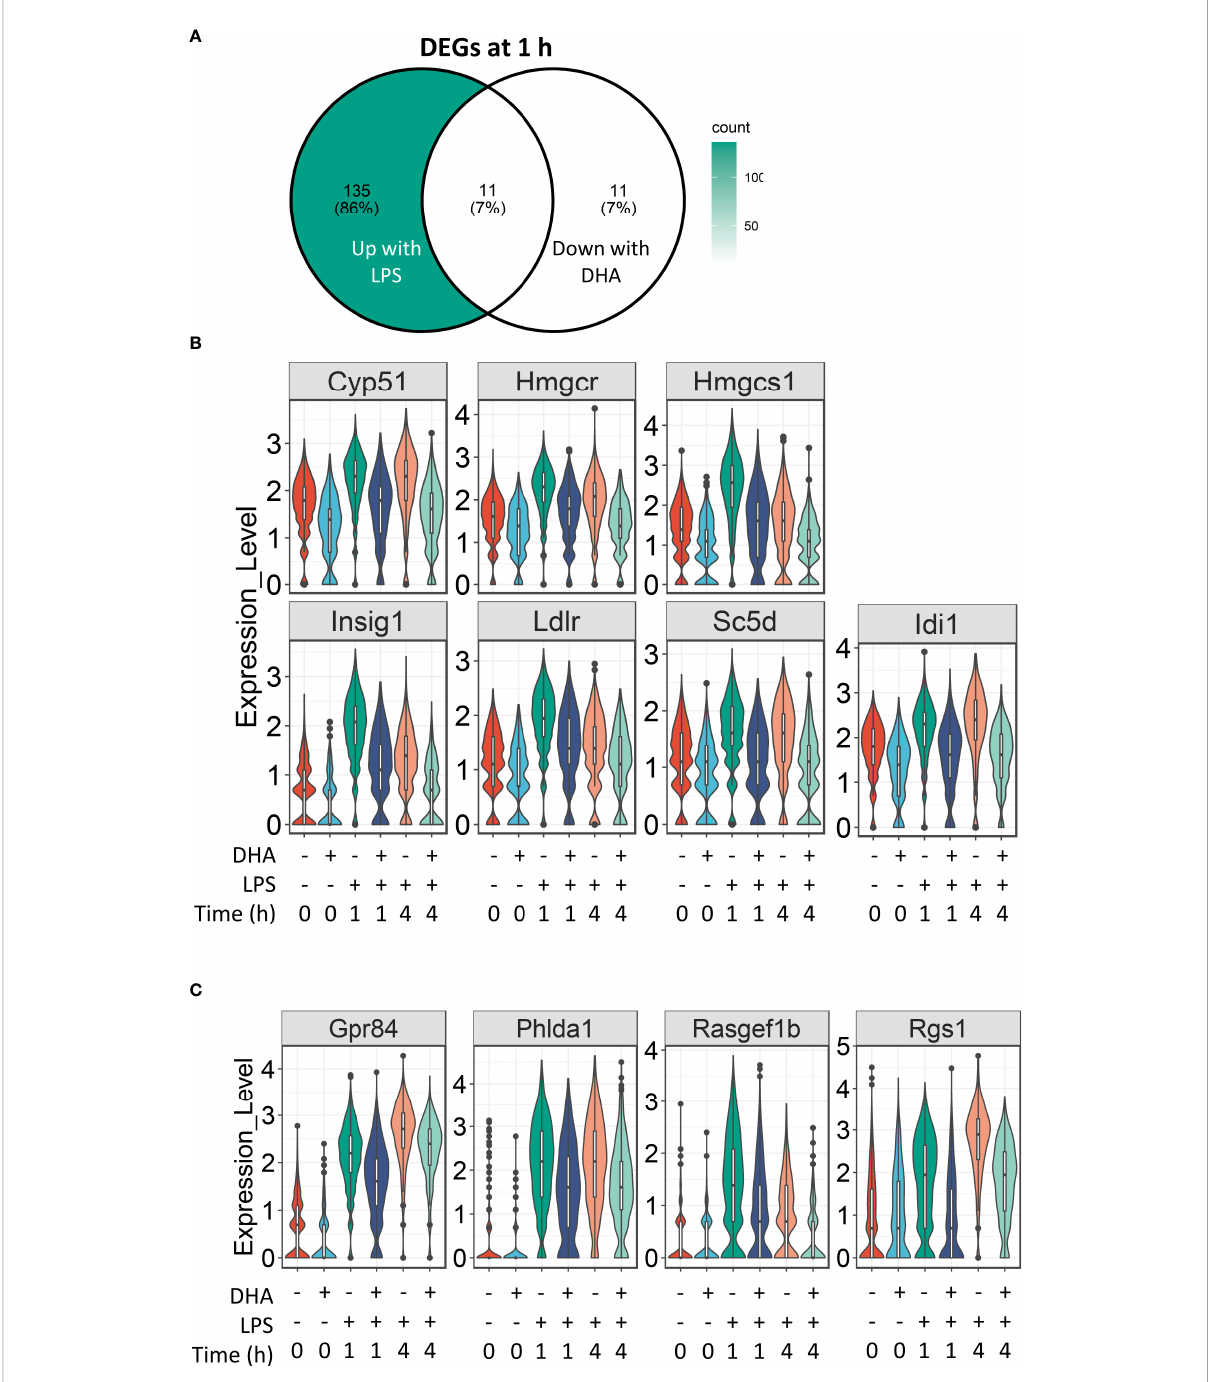
FIGURE 7 DHA suppresses expression of genes associated with cholesterol metabolism and in fl ammatory signaling pathways at 1 h post-LPS treatment. (A) Differentially expressed genes (DEGs) were identi fi ed by using the Seurat FindMarkers function, with thresholds set to select genes with >1.5- fold change in gene expression and genes expressed in at least 25% of groups being compared. DEGs in the “ Down with DHA ” circle of the Venn diagram are downregulated in DHA.LPS.1 relative to Veh.LPS.1 and DEGs in the “ Up with LPS ” circle of the Venn diagram are upregulated in Veh.LPS.1 relative to Veh. The intersection represents LPS-induced genes suppressed by DHA at 1h. (B) 7 of the 11 LPS-induced genes suppressed by DHA involve the cholesterol synthesis pathway. (C) Other LPS-induced genes suppressed by DHA at 1 h are also suppressed by DHA at 4